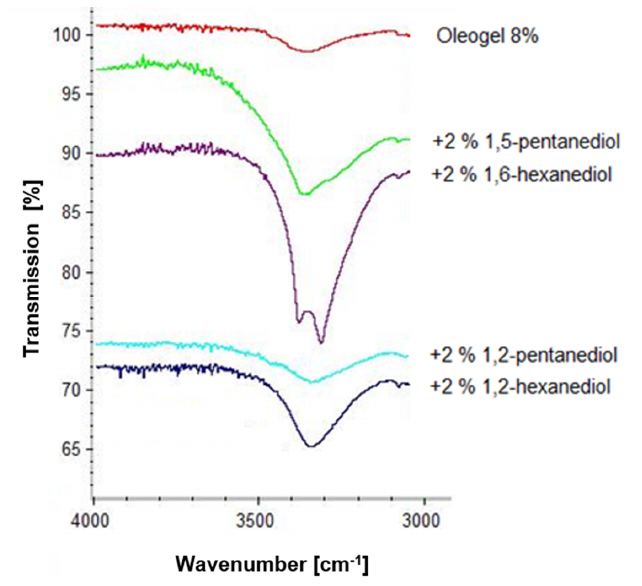
Figure 5. IR spectra of oleogels (8% TE) in sunflower oil with vicinal diols and their corresponding terminal diols